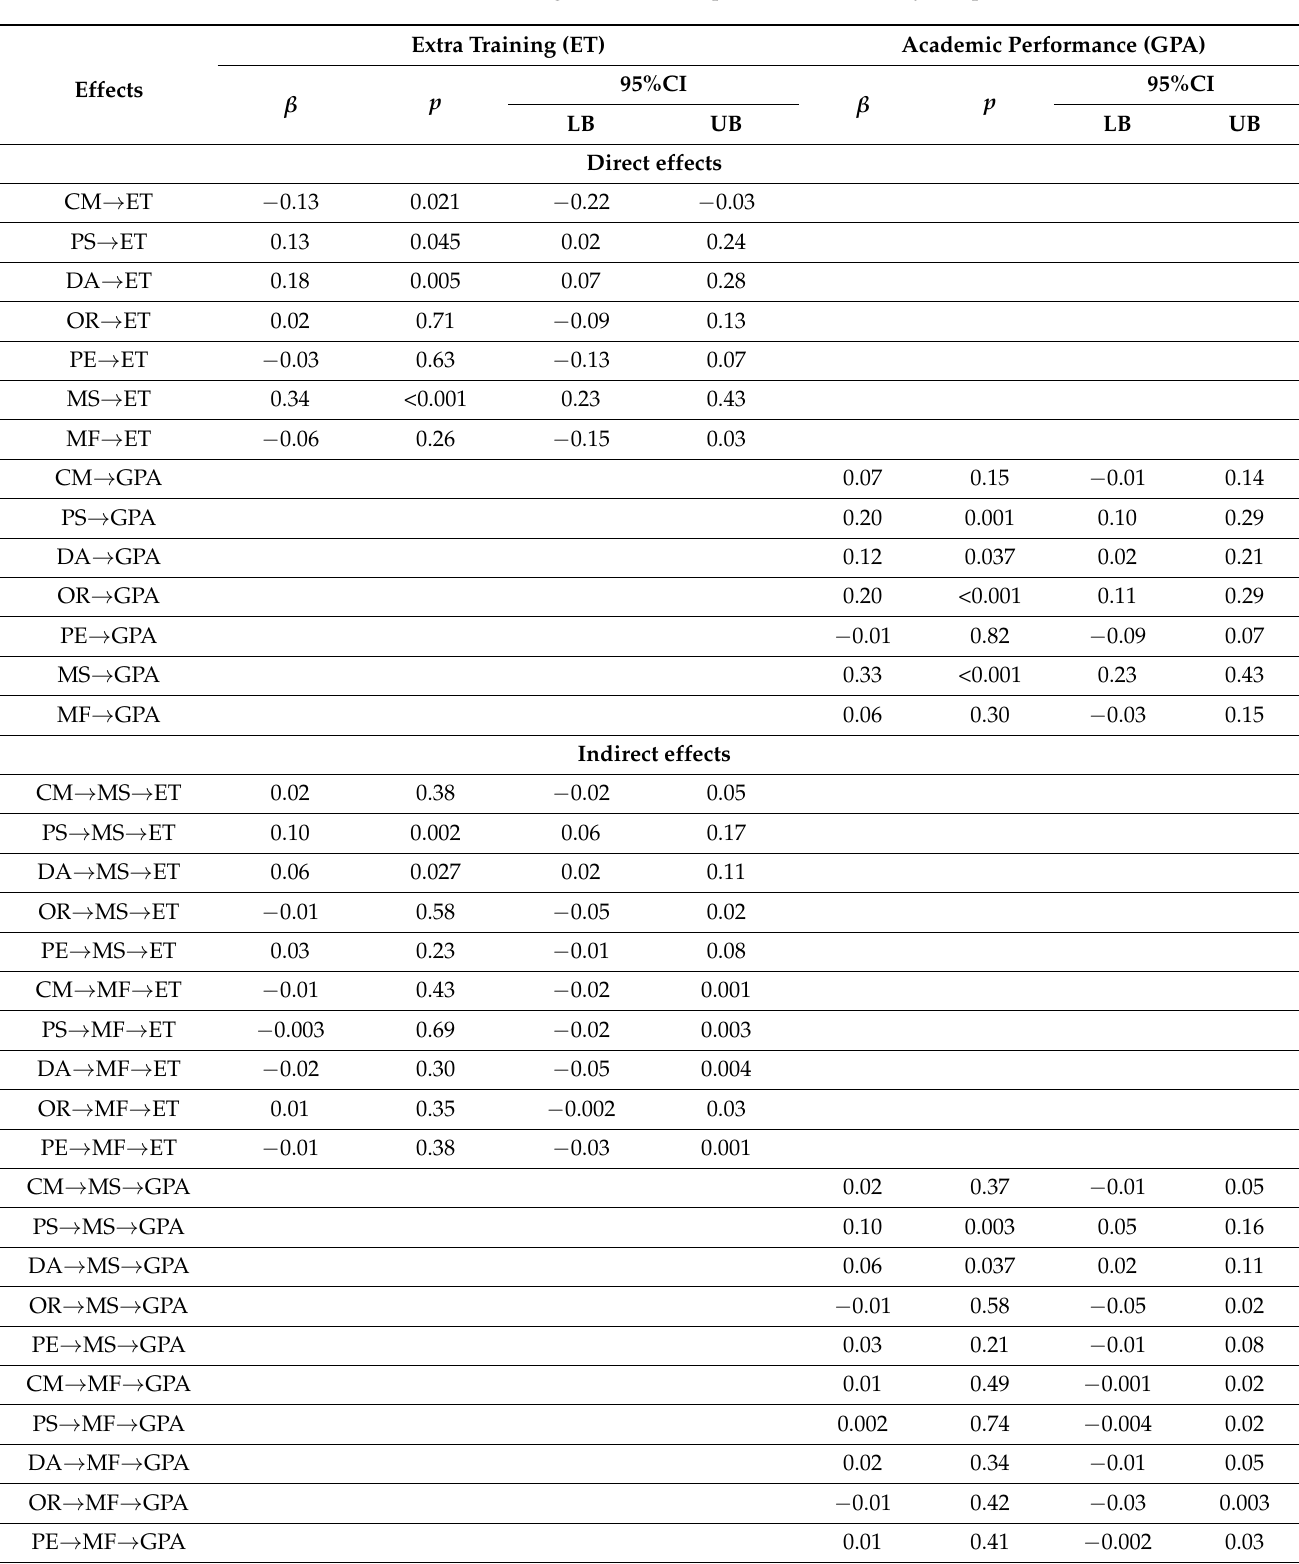
Table 3. Standardized parameter estimates for the direct, indirect, and total effects in the mediation models of extra training and academic performance in study samples ( n =